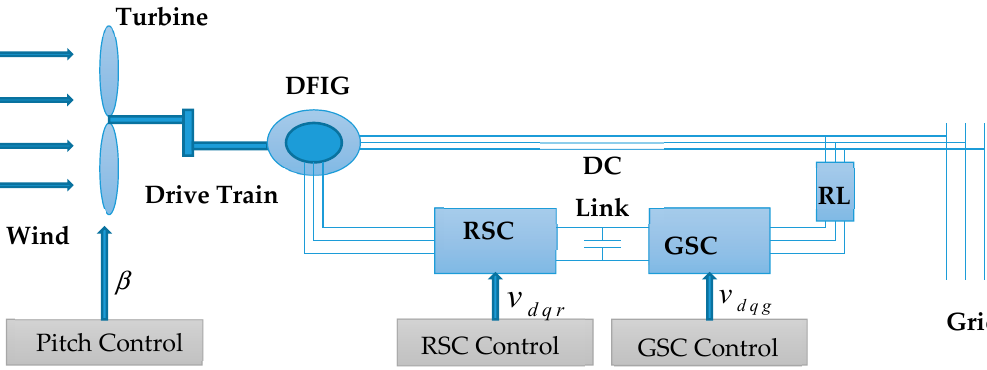
Figure 1. Observe system setup.